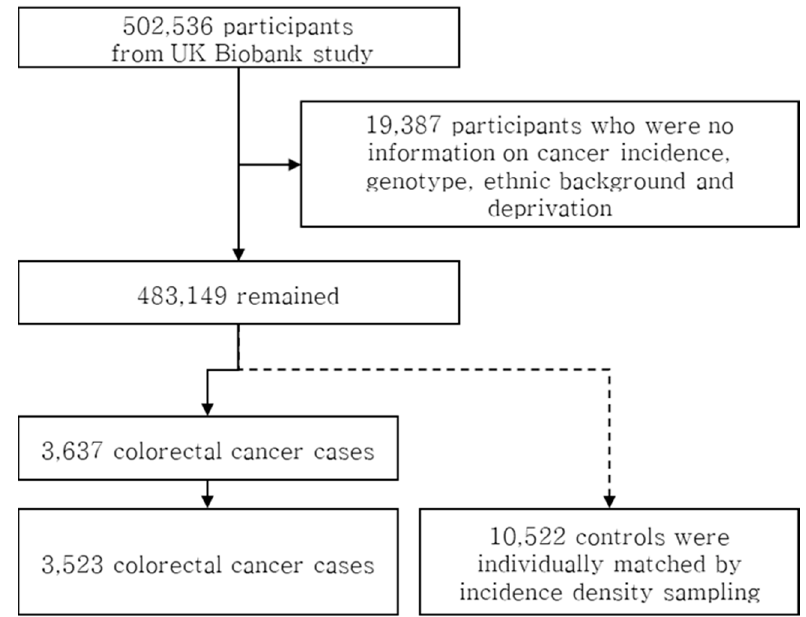
Figure 1. Flow chart of case and control selection.